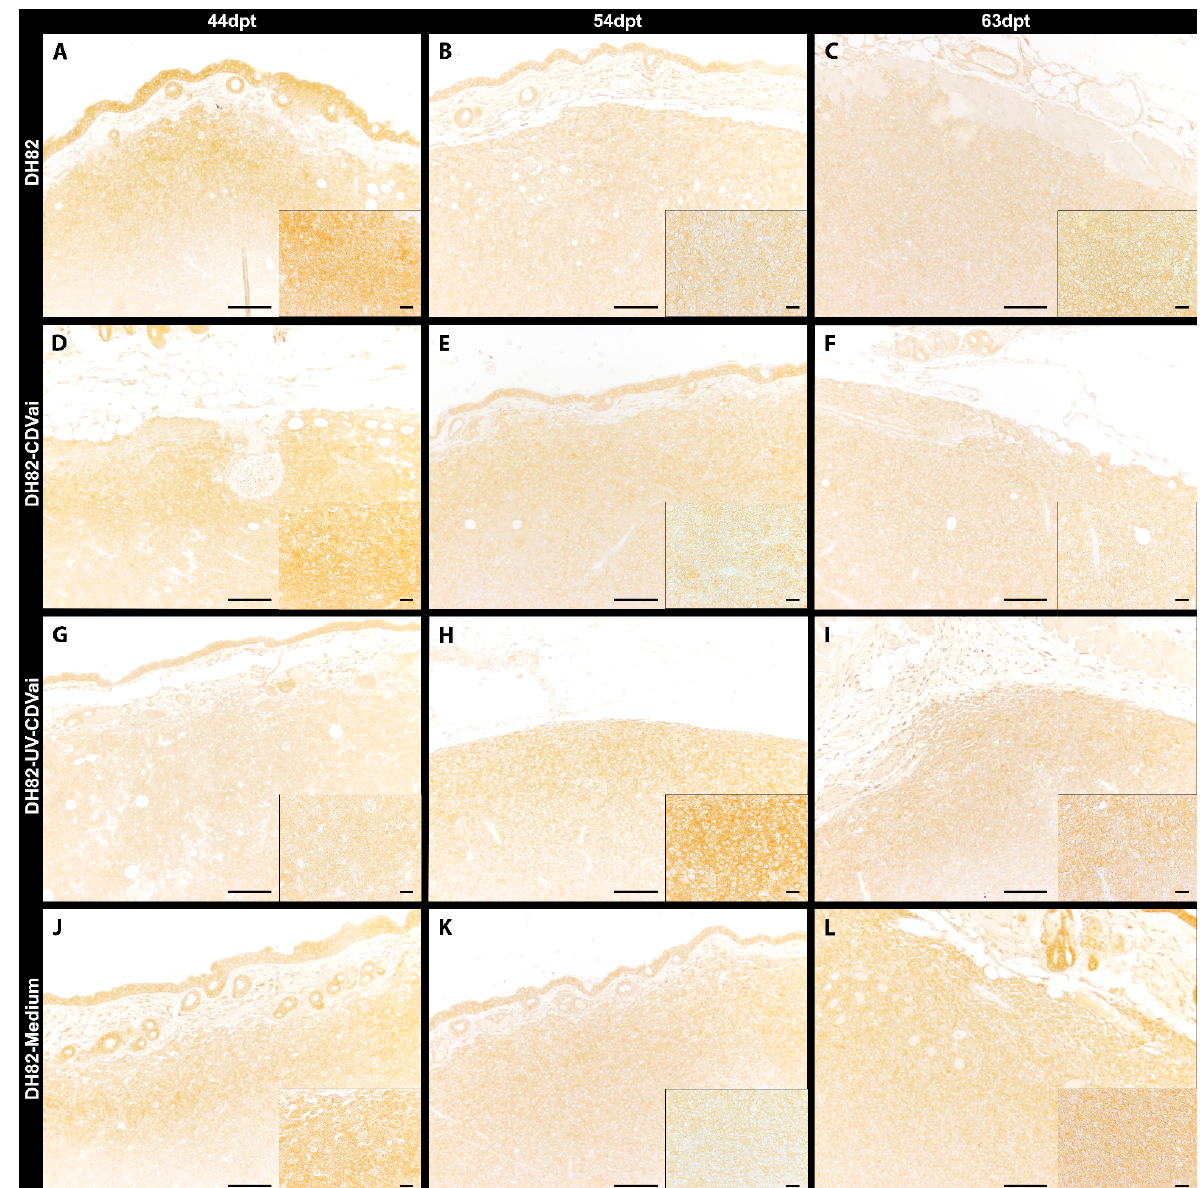
Figure 8. Peripheral TIMP-1 immunolabeling in murine subcutaneous DH82 cell xenografts ( A – L ). ( A – C ) display non- infected (DH82), ( D – F ) intratumorally canine distemper virus (CDV)-infected (DH82-CDVai), ( G – I ) intratumorally UV- inactivated CDV-injected (DH82-UV-CDVai) and ( J – L ) intratumorally medium-injected (DH82-medium) neoplasms at ( A , D , G , J ) 44 days post-transplantation (dpt), ( B , E , H , K ) 54 dpt and ( C , F , I , L ) 63 dpt. Scale bar = 100 μ m and scale bar— insert = 20 μ m.